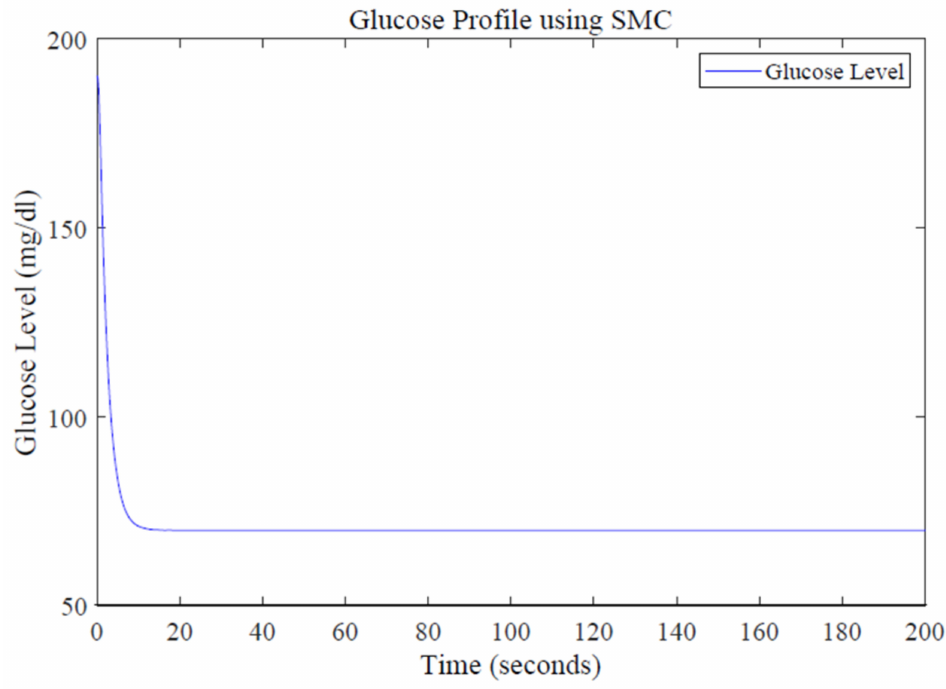
Figure 11. Glucose profile using the SMC